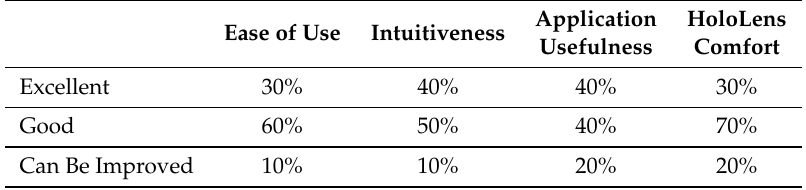
Table 2. Summary of the feedback given by the operators after testing the